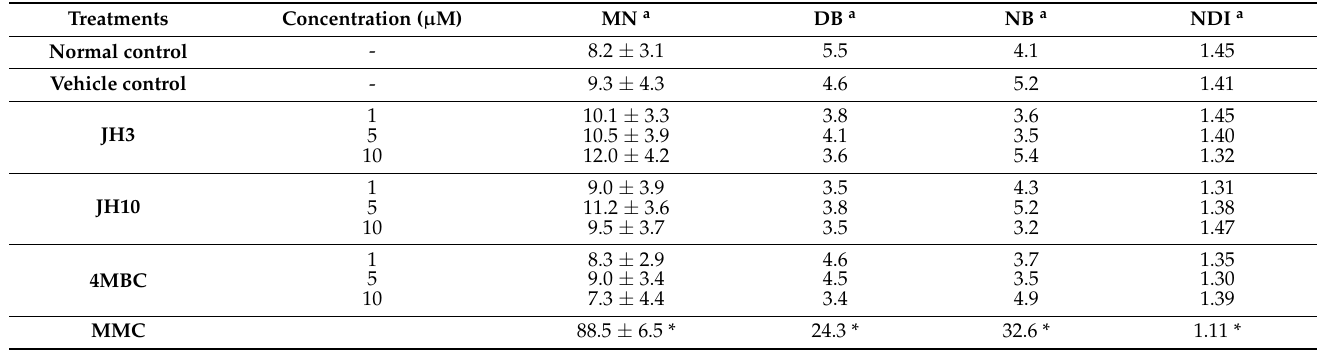
Table 4. Effect of JH3, JH10, and 4-methylbenzylidene camphor (4MBC) on the number of micronuclei (MN), dicentric bridges (DB), and nuclear buds (NB) on binucleated CHO-K1 cells and on the nuclear division index